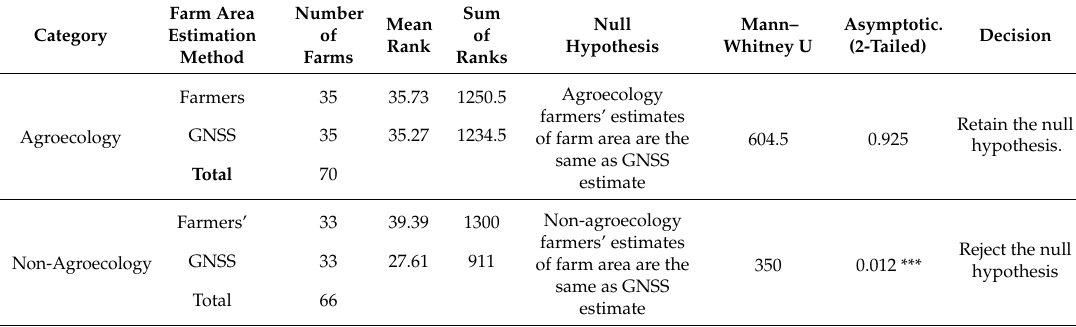
Table 3. Non-parametric test of statistical significance for GNSS and farmer estimates of farm sizes.